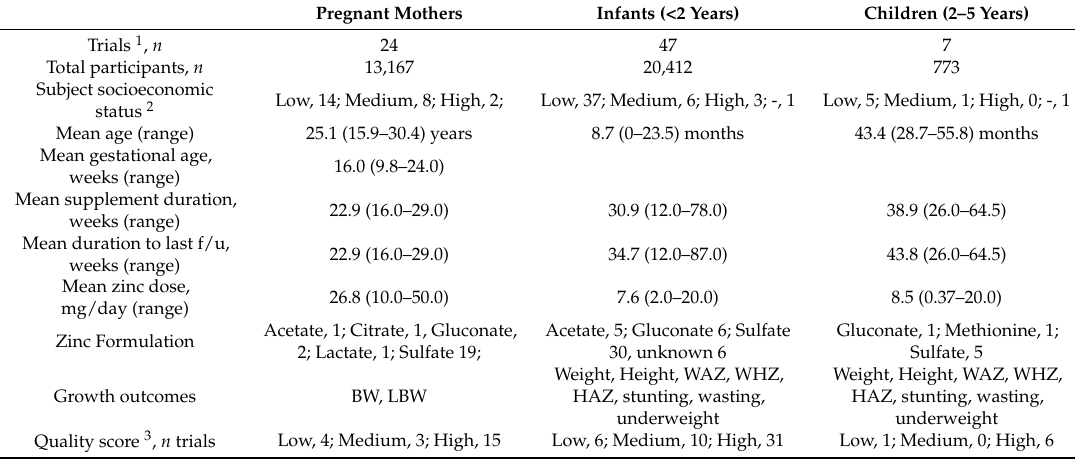
Table 1. Summary of 78 randomized controlled trials included in the meta-analysis of the effect of zinc supplementation during pregnancy, infancy, or childhood on growth outcomes.